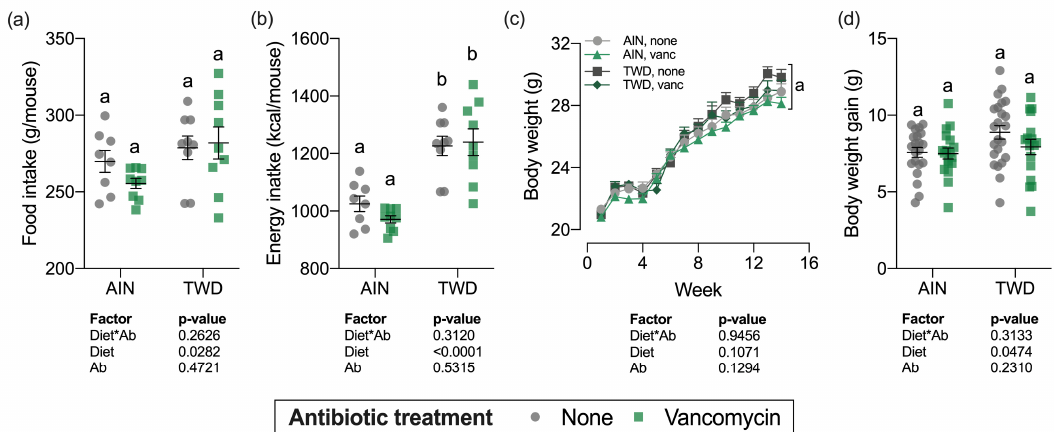
Figure 1. Food and energy intake and body weight gain over the study period. Total estimated food intake ( a ) and total estimated energy intake ( b ) per cage per mouse are shown as individual measurements with the mean ± standard error ( n = 8 to 9 cages). Body weight measurements weekly ( c ) and body weight gain (differential of day 98 and day 0 weights) ( d ) are shown as mean ± standard error ( c ) or individual measurements with the mean ± standard error ( d ) (initial n = 36/group, final n = 17 to 23/group). Main effects of experimental factors diet, antibiotic treatment and diet*antibiotic interaction are shown as determined by generalized linear mixed model, and different letters indicate experimental groups are significantly different ( p < 0.05) as determined by the Tukey HSD post hoc test (for terminal time point only for panel c). Abbreviations: AIN, the AIN93G diet; TWD, the total Western diet; Ab, antibiotic; vanc,